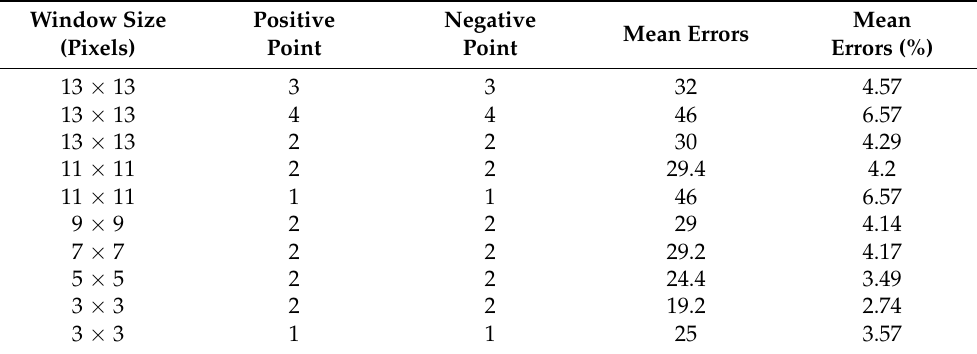
Table 7. Average